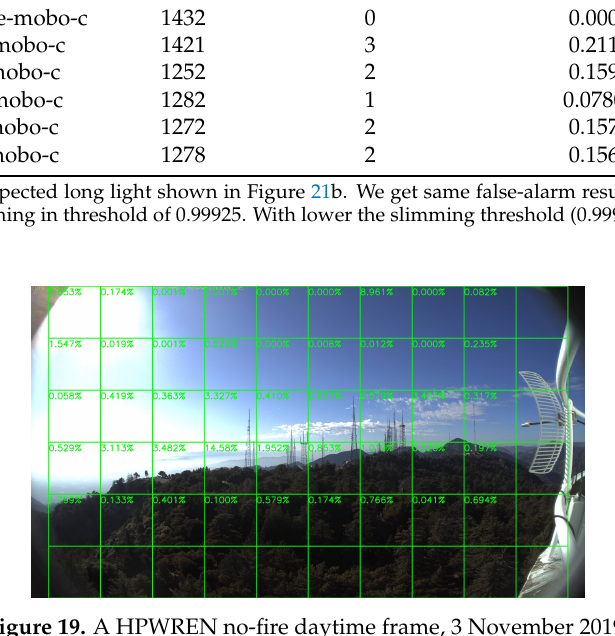
Figure 19. A HPWREN no-fire daytime frame, 3 November 2019.